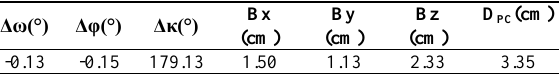
Table 3. Average calculated values of ROPs components (Δω, Δφ and Δκ in degree and B X , B Y and B Z in centimeter).